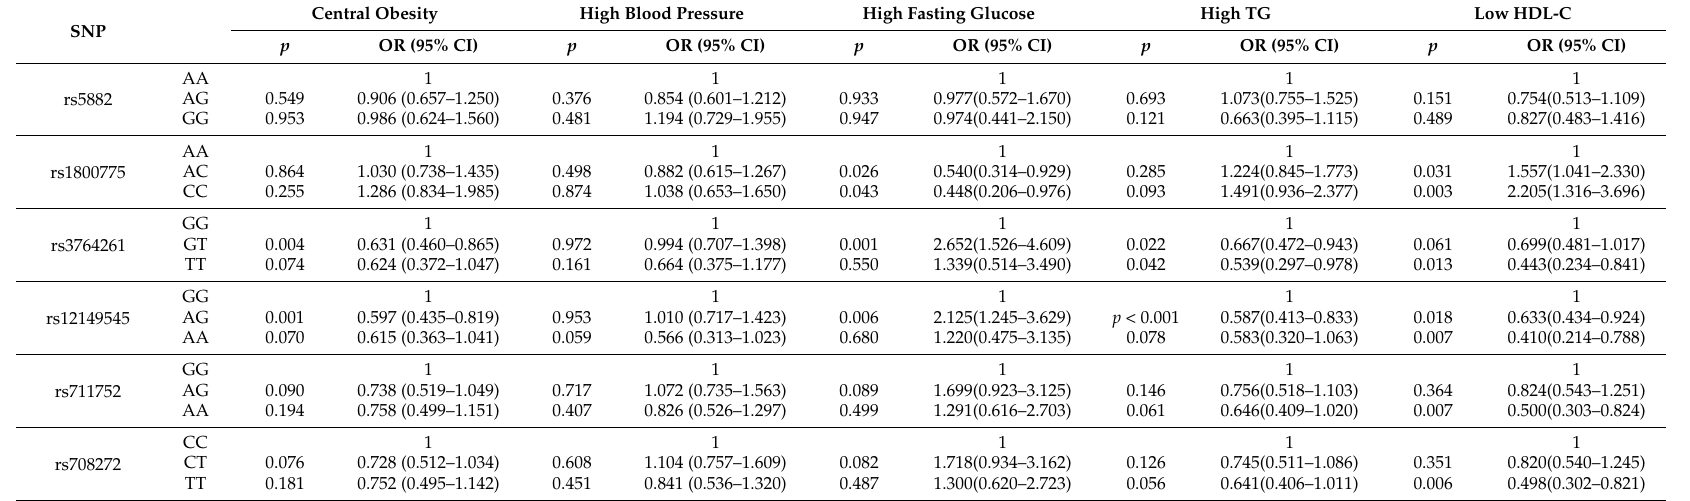
Table 5. Risk factor analysis between six CETP SNPs and five components in